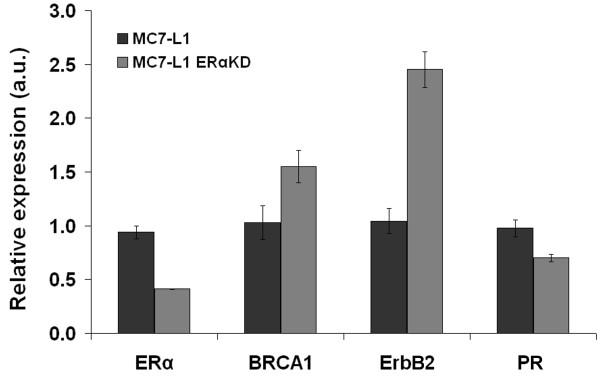
Comparative qPCR. Murine ERα, BRCA1, ErbB2, and PR mRNA expression were compared in MC7-L1 ER+ and ERαKD cell lines. RNA extraction was performed in triplicate for each cell line, and each qPCR reaction (each sample, each gene) was repeated thrice. Data were expressed relative to one of the three MC7-L1 samples for each gene.